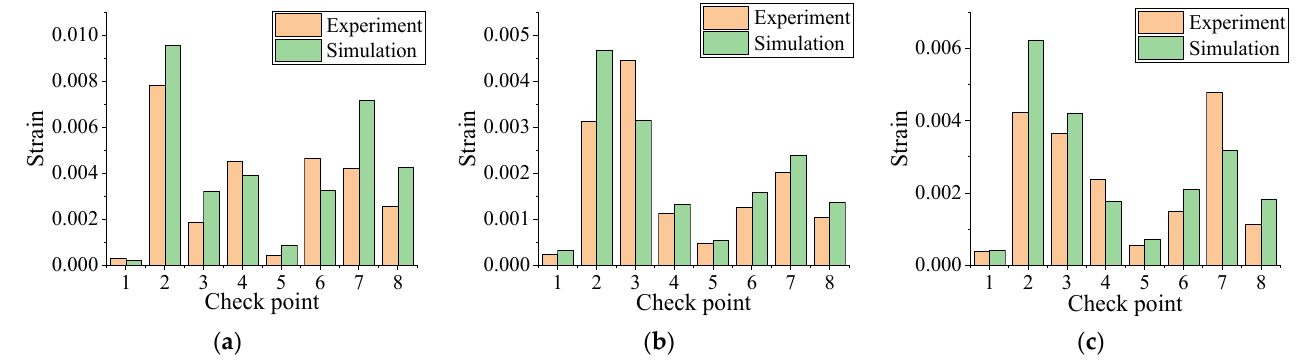
Figure 11. Comparison of strain response between transient analysis and test results. ( a ) 30 mm, 7 Hz; ( b ) 30 mm, 5 Hz; ( c ) 40 mm, 5 Hz.